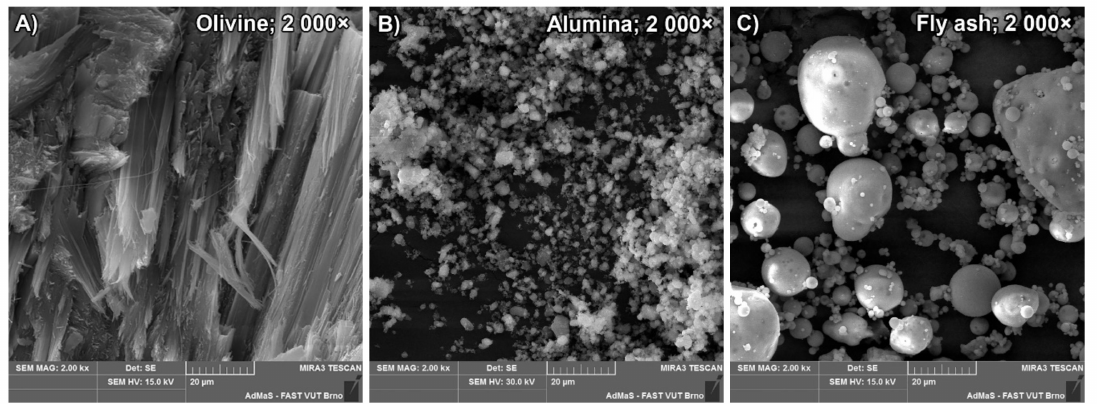
Figure 2. SEM microphotographs of selected raw materials: ( A ) olivine, ( B ) alumina and ( C ) fly ash; magnification = 2000 ×